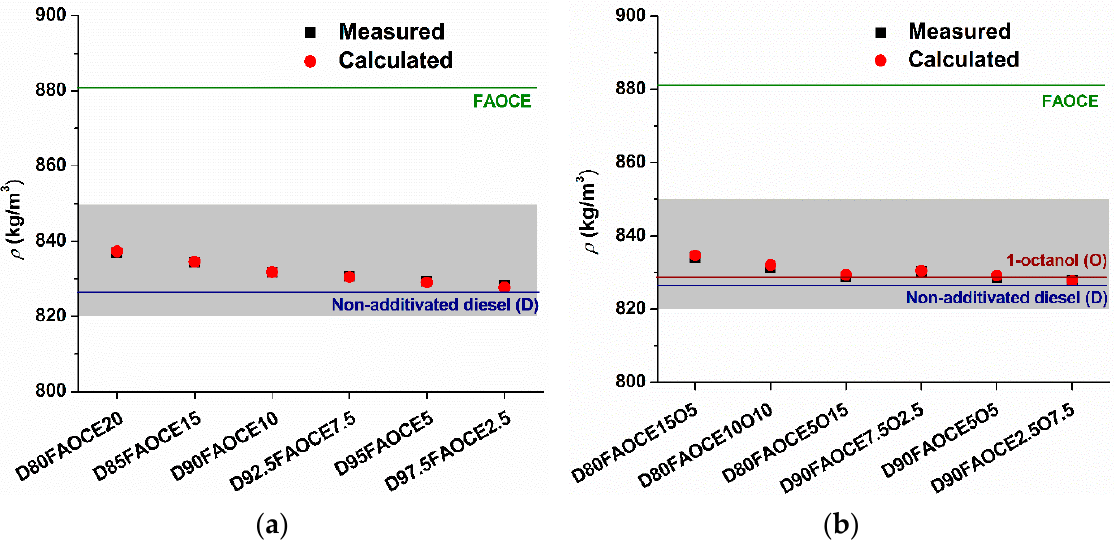
Figure 7. Comparison of measured and calculated density values of binary ( a ) and ternary ( b ) blends of 80, 85, 90, 92.5, 95, and 97.5 vol% diesel.